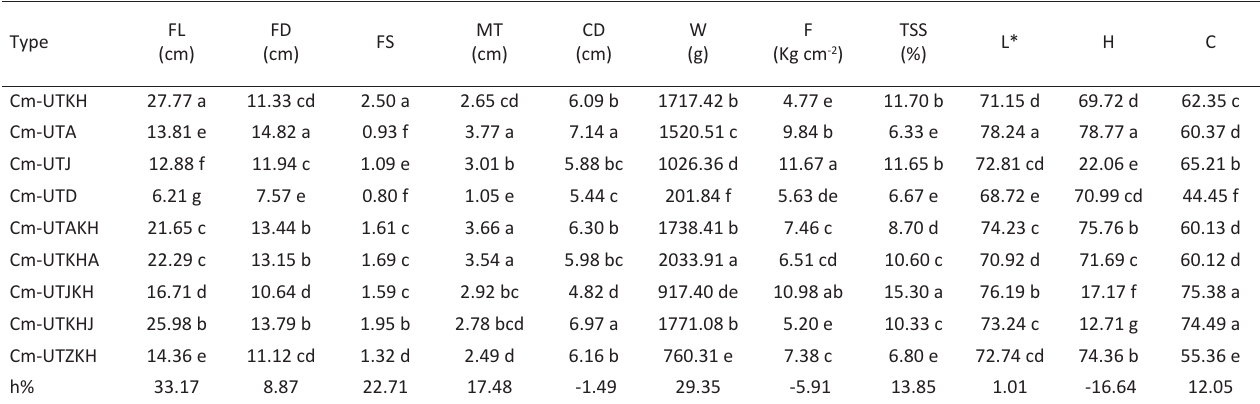
Types with similar letters in each column have no significant differences for the monitored trait in that column (P<0.05). h% represents heterosis in each trait compared to med­parents.